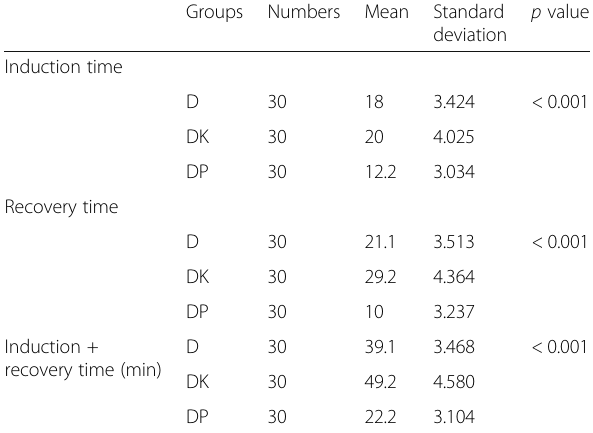
Table 8 Ramsay sedation score 5 min post induction group